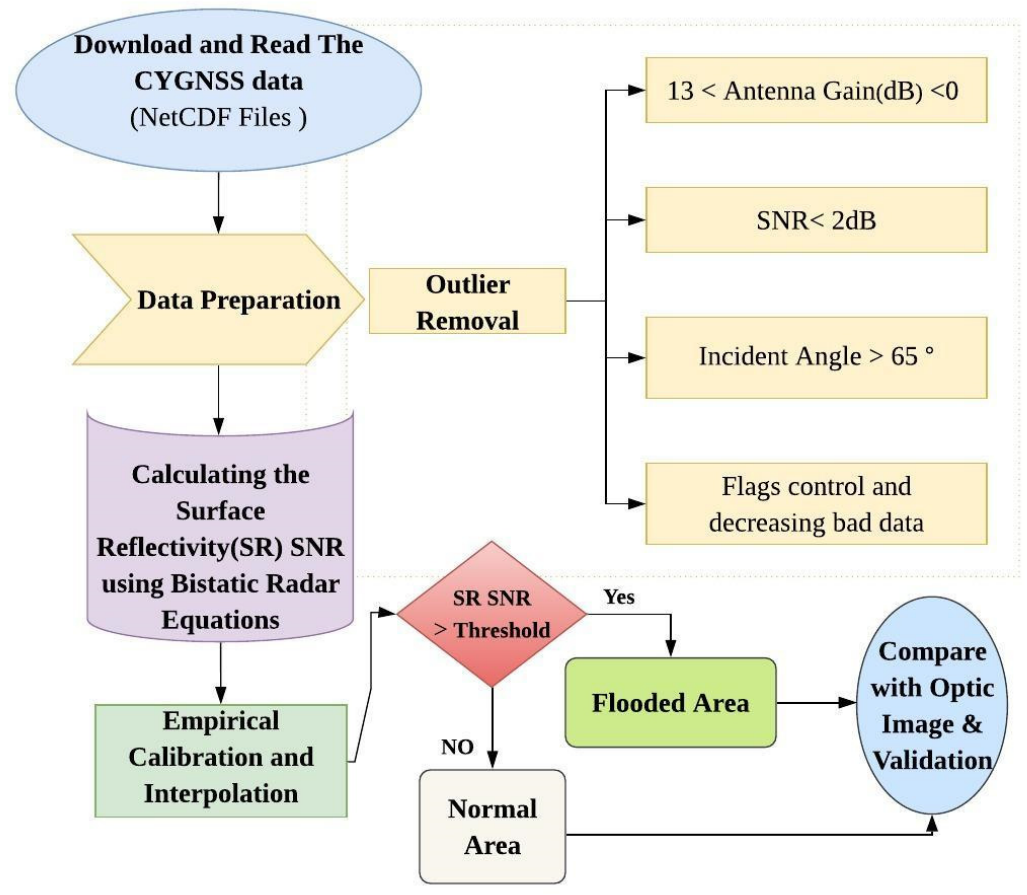
Figure 5. Methodology flowchart based on the bistatic radar concept and using CYGNSS data.